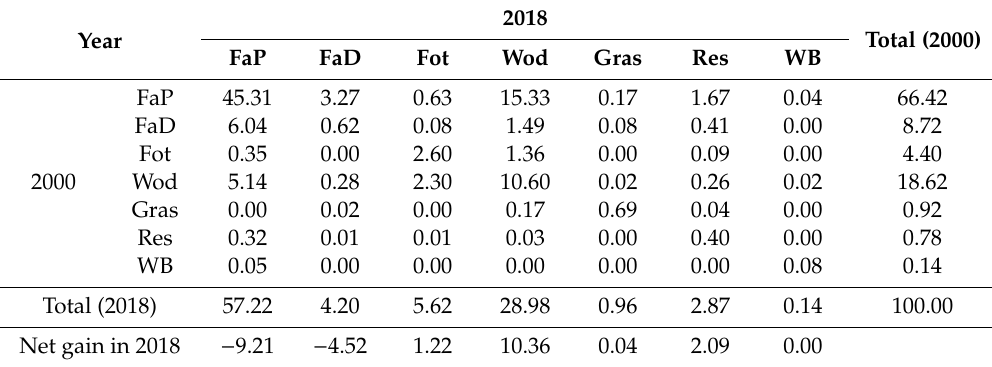
Table 2. Percentages of conversion of each LULC during 2000–2018 (% of total area).